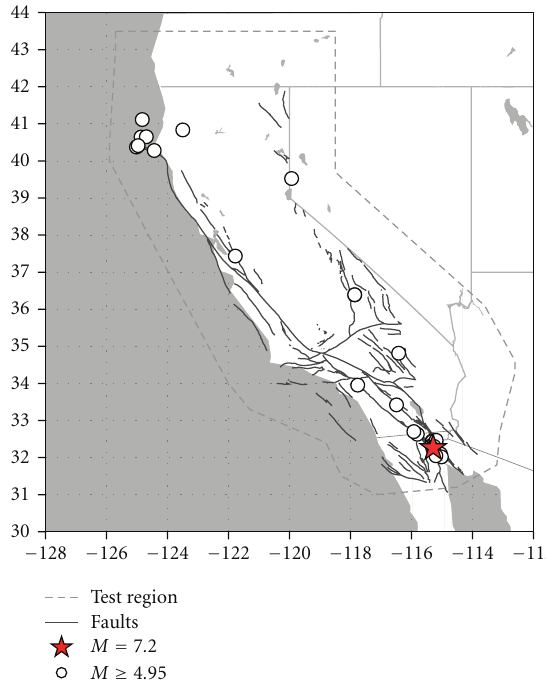
Figure 1: Map of the test region, the coast of California, major faults, and the 31 earthquakes with M ≥ 4.95 that occurred in the test region. The earthquakes are given in Table